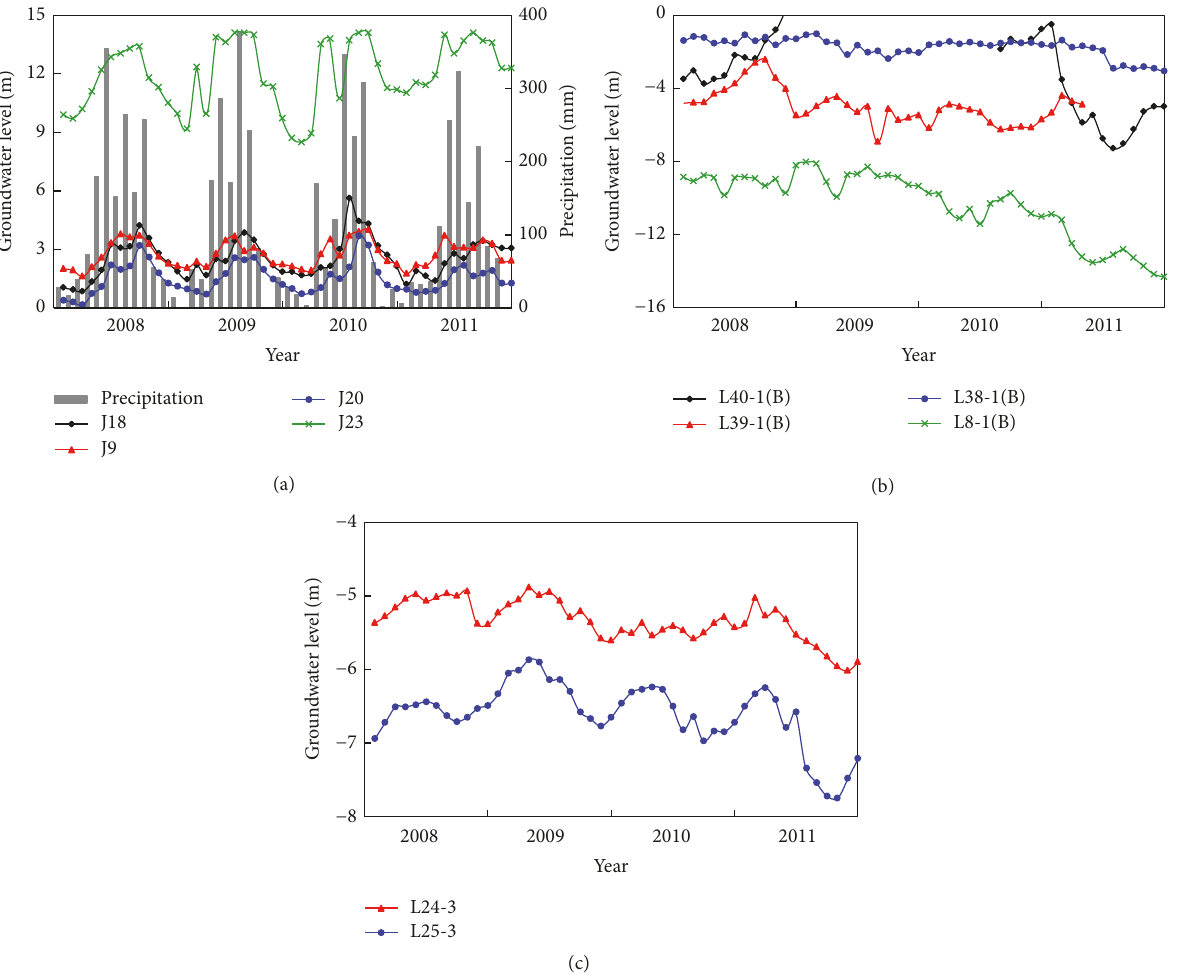
Figure 11: Observed groundwater level dynamics in the multilayered aquifers during 2008–2011. (a) Groundwater level dynamics of the unconfined aquifer. (b) Groundwater level dynamics of the middle confined aquifer. (c) Groundwater level dynamics of the deep confined